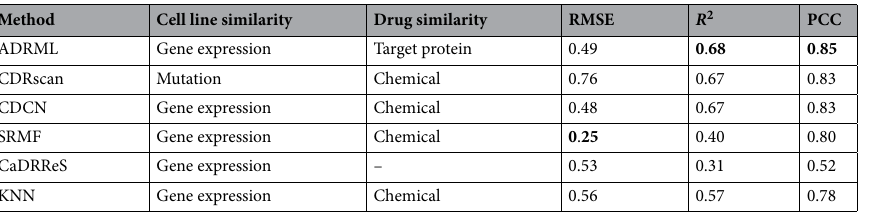
Table 3. Comparison of methods’ performance on CCLE dataset. The methods were evaluated by averaging over 30 repetitions of fivefold cross-validation on cell line-drug pair. The best results of each criterion are shown in boldface.